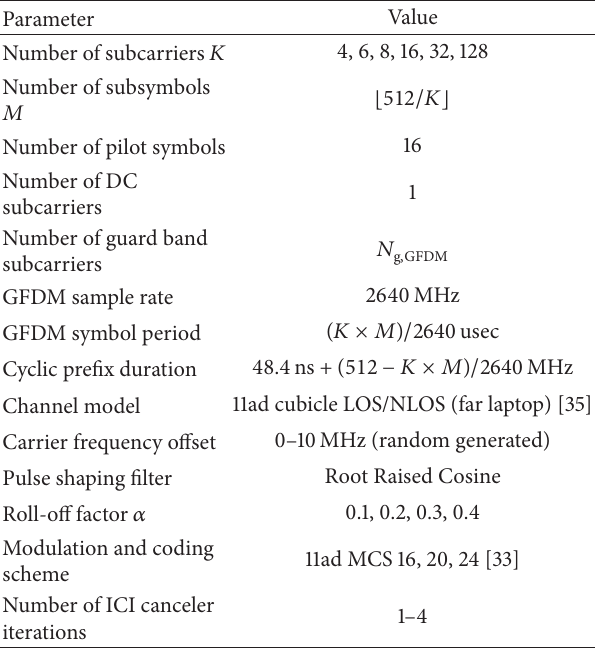
Table 2: IEEE 802.11ad GFDM parameters.